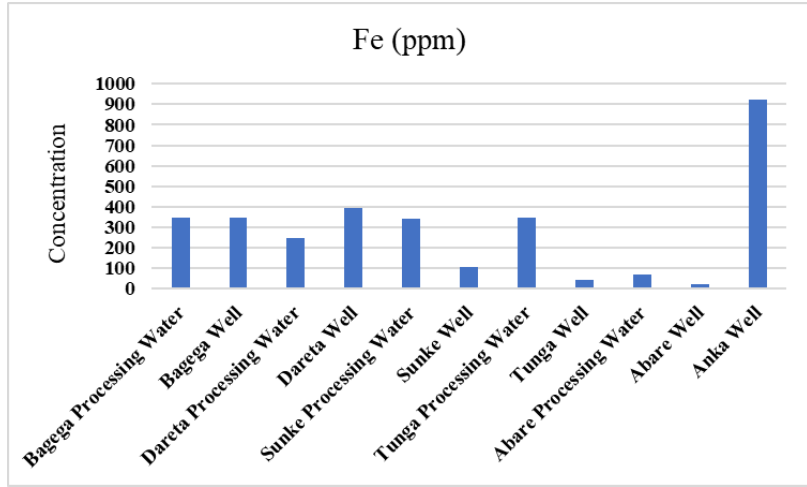
Figure 3. Mean iron (Fe) concentrations (ppm) in water samples of the study